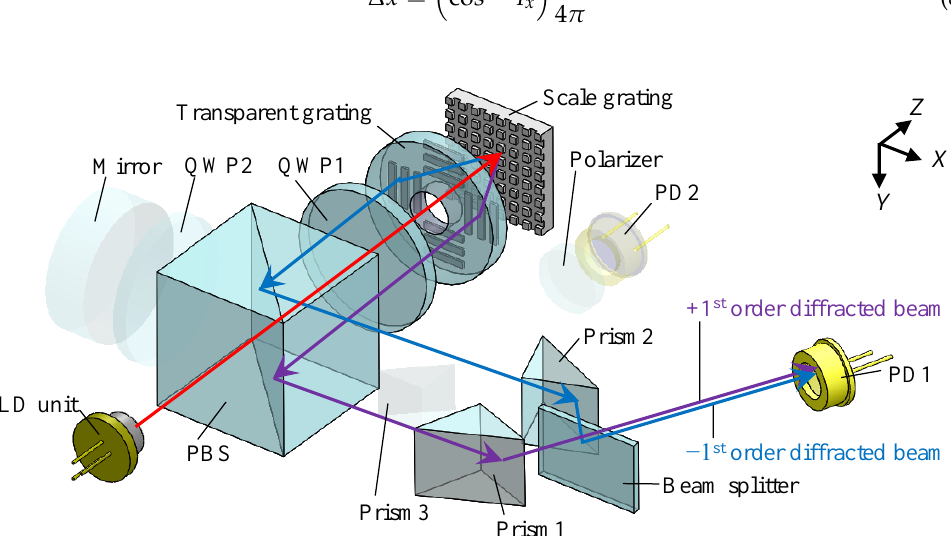
Figure 2. Optical system related to the X -directional displacement measurement (the transparency of the unrelated components is increased).